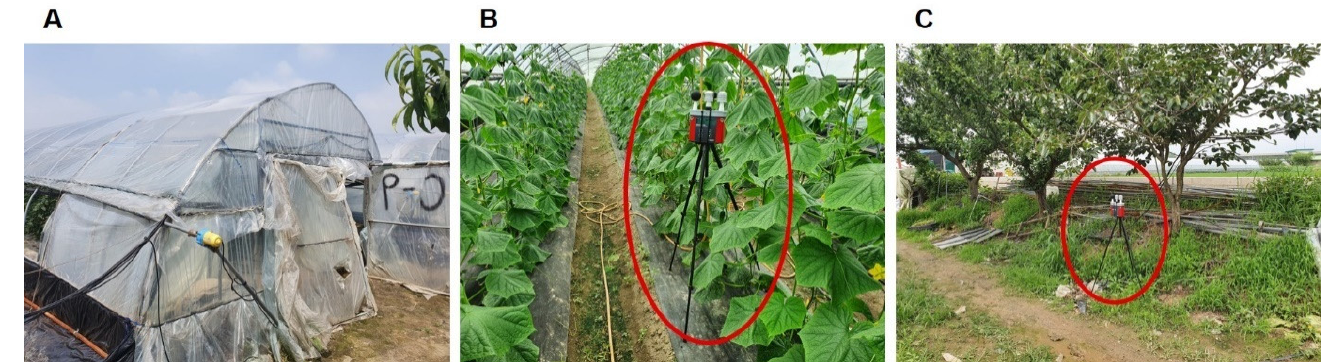
Figure 1. Sampling location. ( A ) Typical greenhouse. ( B ) Wet-bulb globe temperature (WBGT) sampling inside the greenhouse. ( C ) WBGT sampling outside the greenhouse.